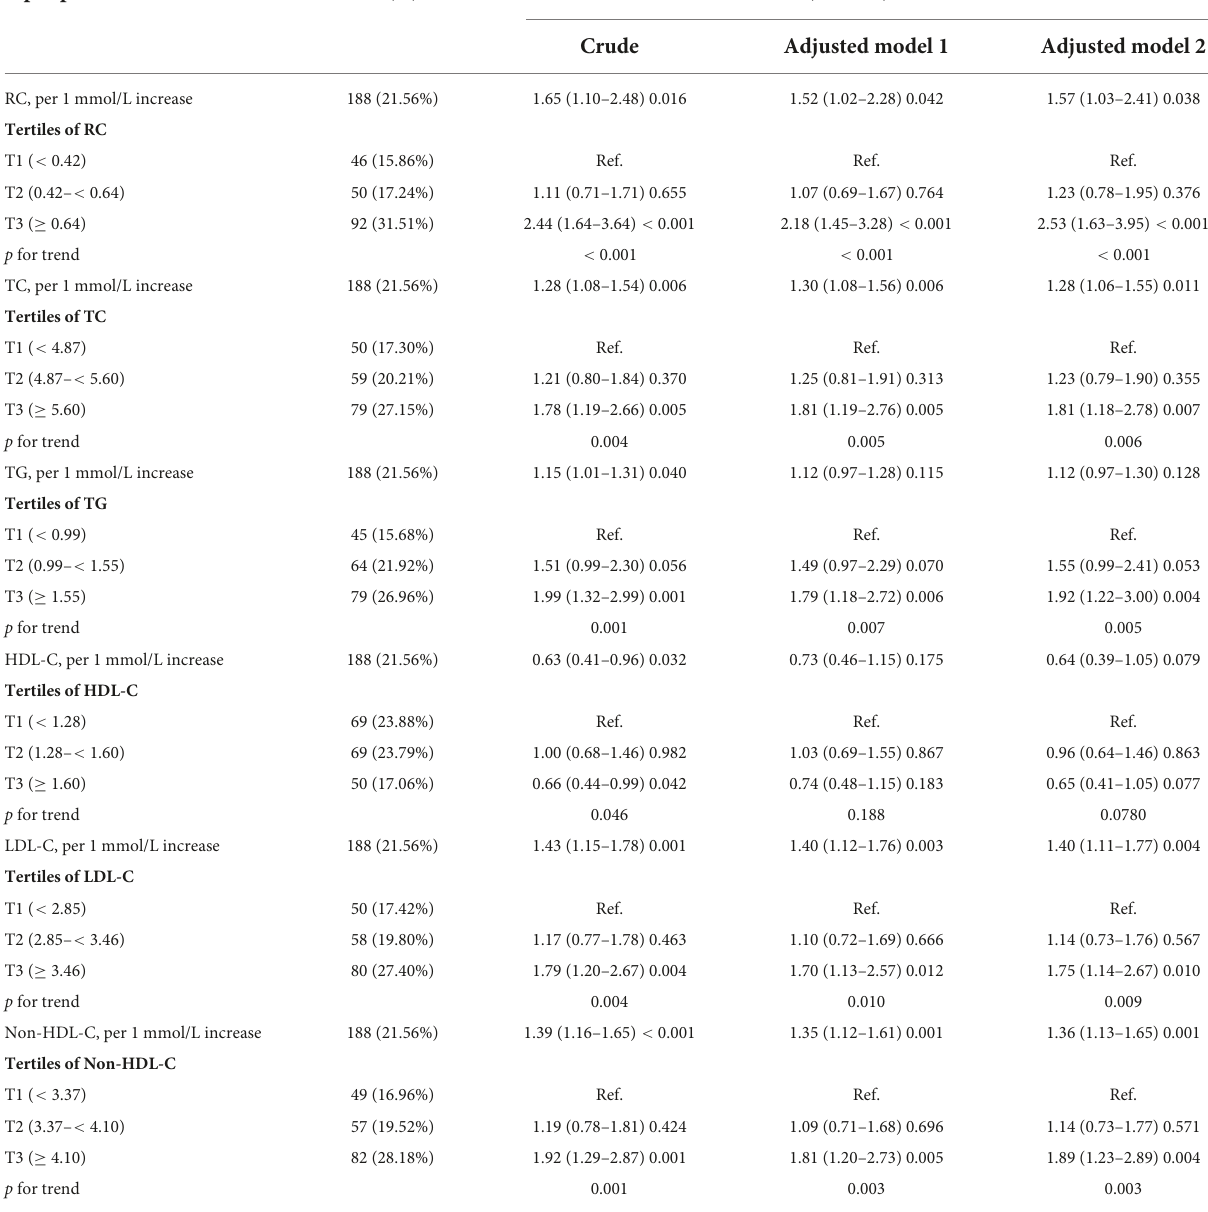
TABLE 2 Logistic regressions for the effects of baseline lipid parameters and new-onset carotid plaque. Lipid